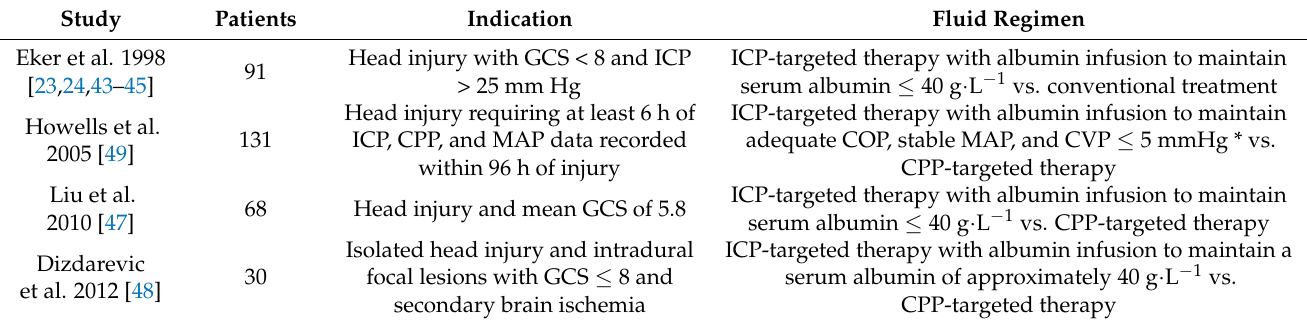
Table 2. Attributes of the studies included in the